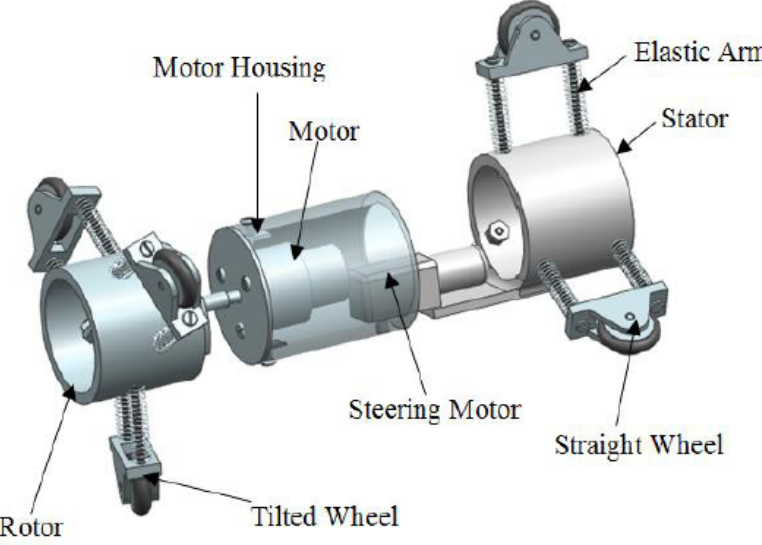
Figure 37. Solid model of a screw-drive robot, which is capable of moving along the x-axis, y-axis and z-axis in straight and curved pipelines. Reprinted under Creative Commons CC BY-NC-ND license